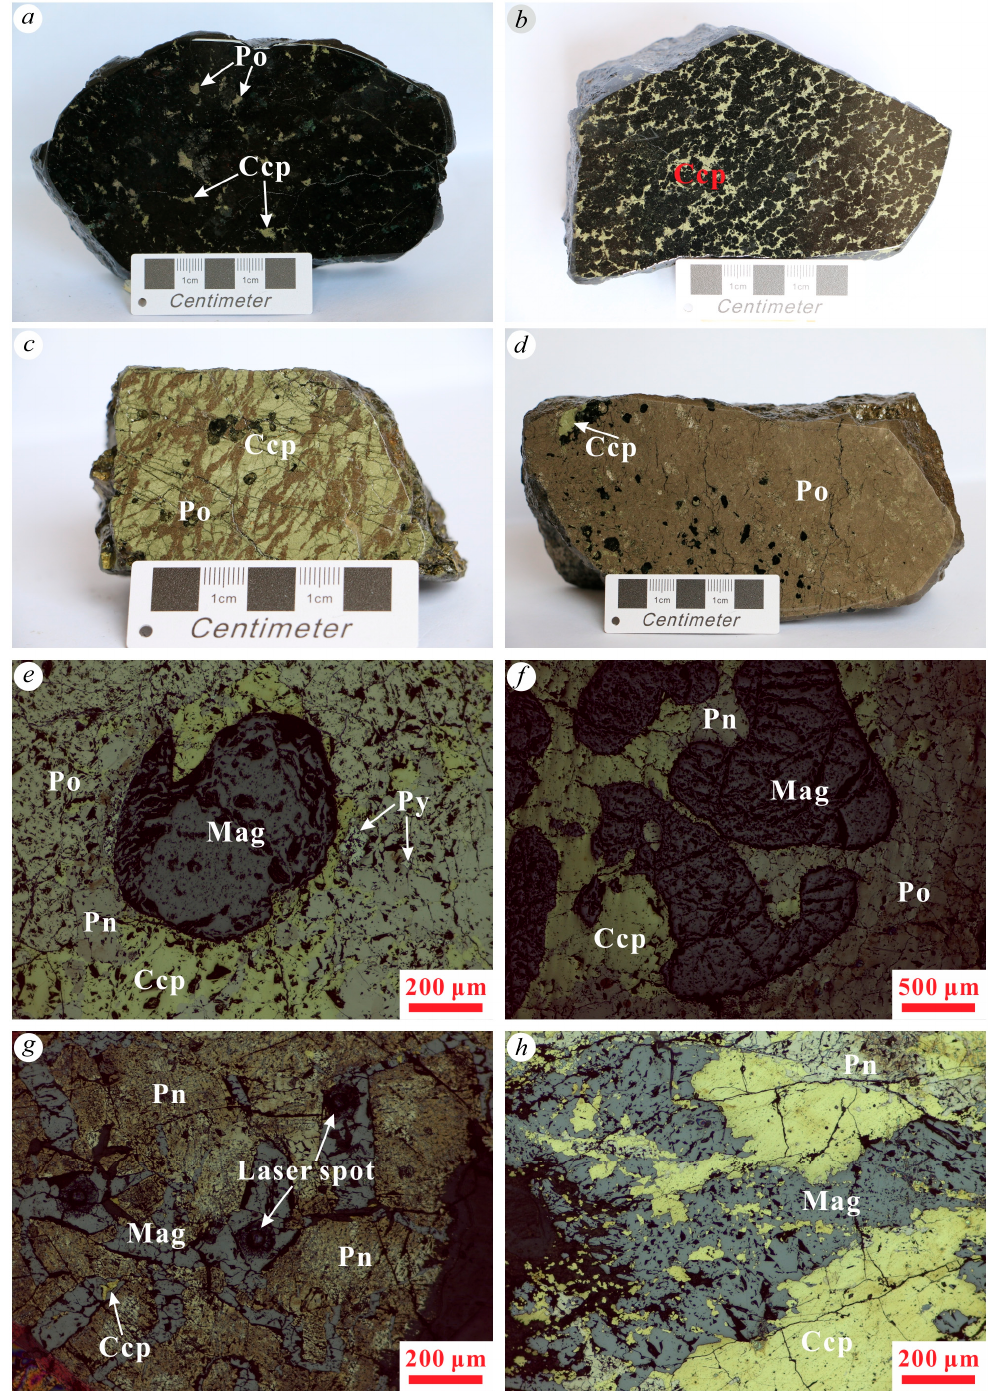
Figure 3. The main types of sulfide ores and different magnetite types in various sulfide ores of the Jinchuan Ni-Cu-PGE deposit: ( a ) Disseminated sulfide ore, ( b ) net-textured sulfide ore, ( c ) massive Cu-rich sulfide ore, ( d ) massive Ni-rich (or Fe-rich) sulfide ore, ( e , f ) Type I magnetite in massive Ni- and Cu-rich sulfide ores, and ( g,h ) Type I and III magnetite in disseminated Cu-rich sulfide ores. Abbreviations: Ccp, chalcopyrite; Mag, magnetite; Pn, pentlandite; Po, pyrrhotite; Py, pyrite.